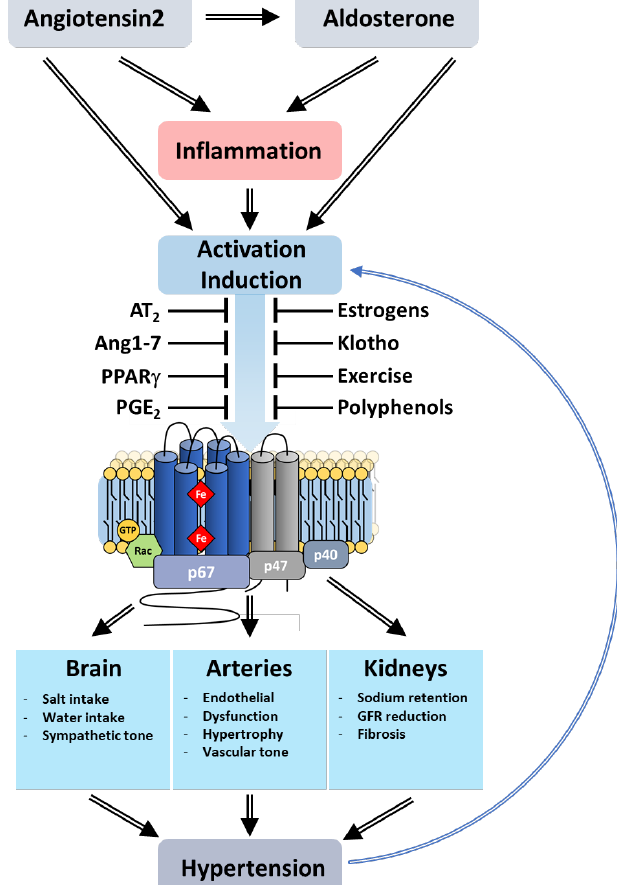
Figure 23. Role of NOX in hypertension. Angiotensin II leads to the activation and expression of NOX via the AT 2 receptor, aldosterone, inflammation and increased vascular tone. Multiple factors including prostaglandin E 2 (PGE 2 ), exercise, estrogen, and angiotensin, via the AT 2 receptor, contribute to limit this process. NOX located in the brain, arteries and kidneys promote the development of hypertension through various mechanisms. In the kidney, for instance, activation of NOX presumably destabilizes the tubulo-glomerular feedback loop and the glomerular filtration rate (GFR) [428].